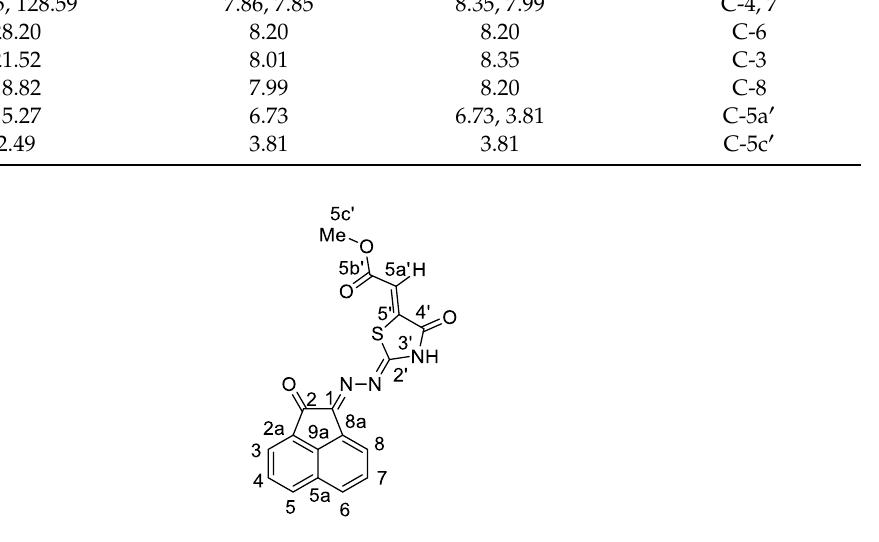
Figure 2. The distinctive carbons in compound 7a.